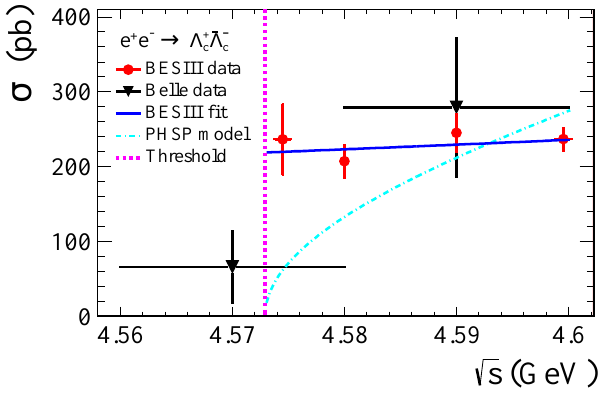
¯ Λ − by BESIII and c c